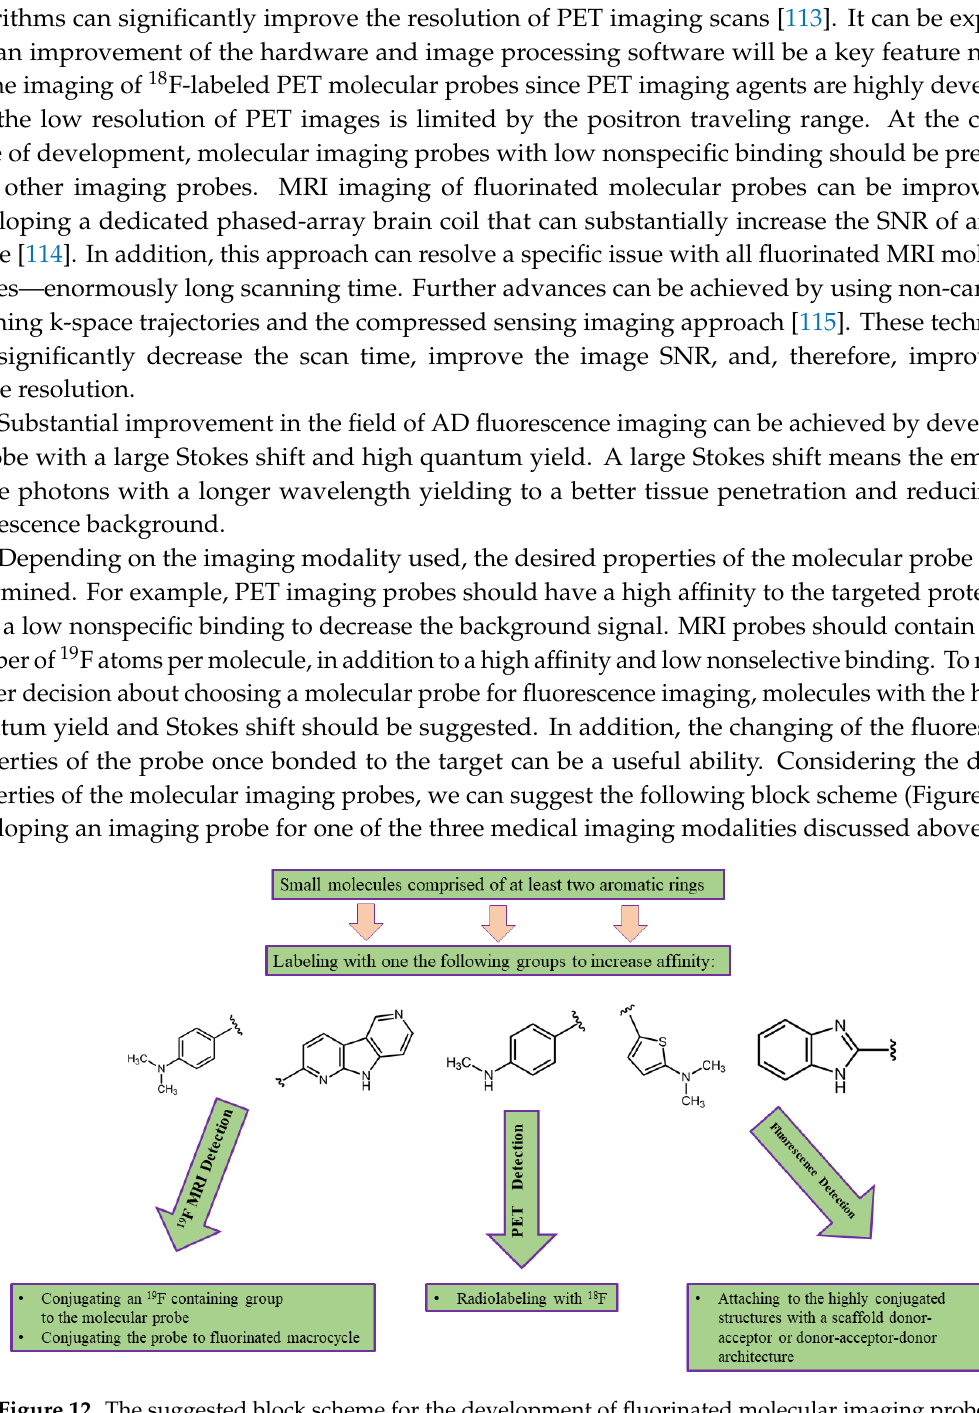
Figure 12. The suggested block scheme for the development of fluorinated molecular imaging probes for AD detection using one of the following medical imaging modalities: MRI, PET, and fluorescence imaging. Probes can be adjusted for single-photon emission computed tomography (SPECT) by radiolabeling with 99m Tc or 131 I instead of 18 F.